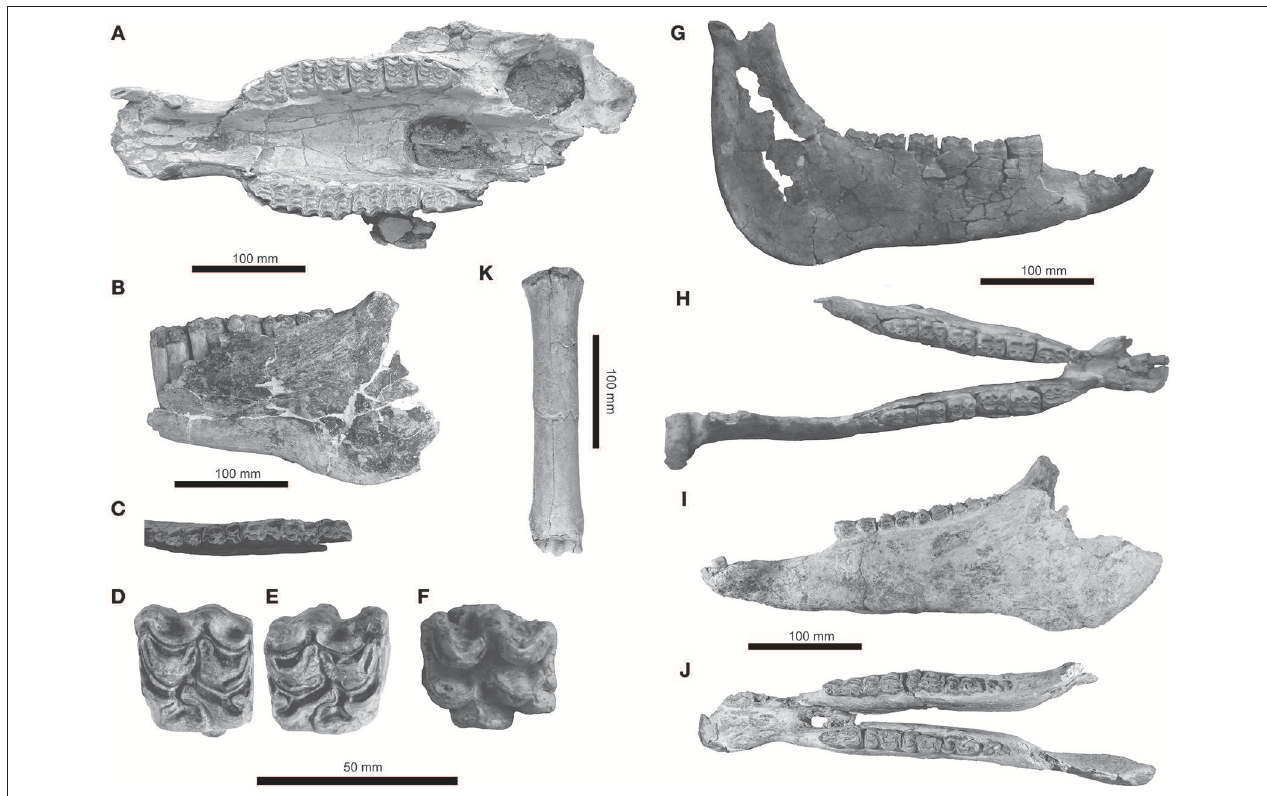
FIGURE 4 | Equus mexicanus from southern Mexico. UMPE 521, skull in (A) palatal view. UMPE 554, left mandible in (B) lateral and (C) occlusal views. (D) IHNFG-4886, M1; (E) IHNFG-5660, P4, and (F) UMPE 908, P4 in occlusal views. UMPE 643, mandible in (G) lateral and (H) dorsal views. IHNFG-4872, mandible in (I) lateral and (J) dorsal views. UMPE 489, left metatarsal in (K) cranial view.